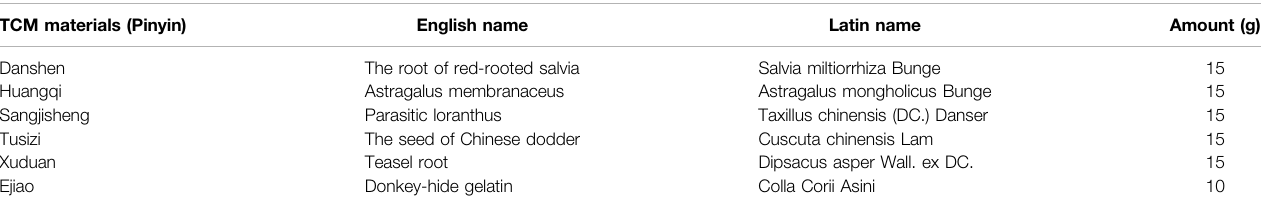
TABLE 1 | The composition of Bushen Huoxue Decoction